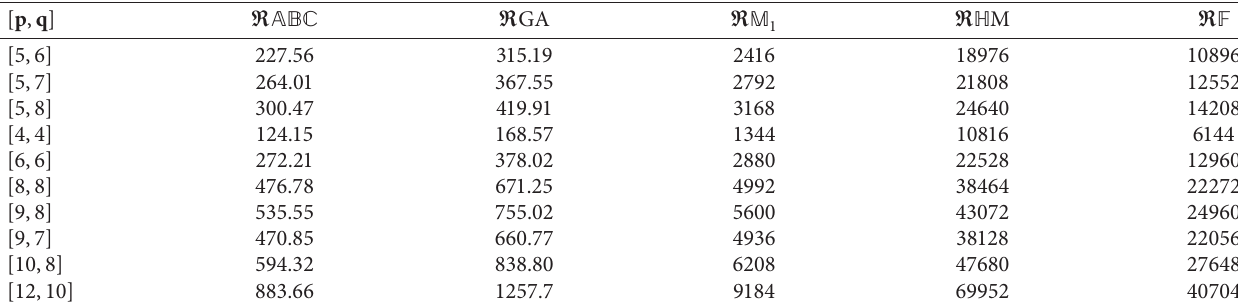
, R H M, and R F for Case 2. 1